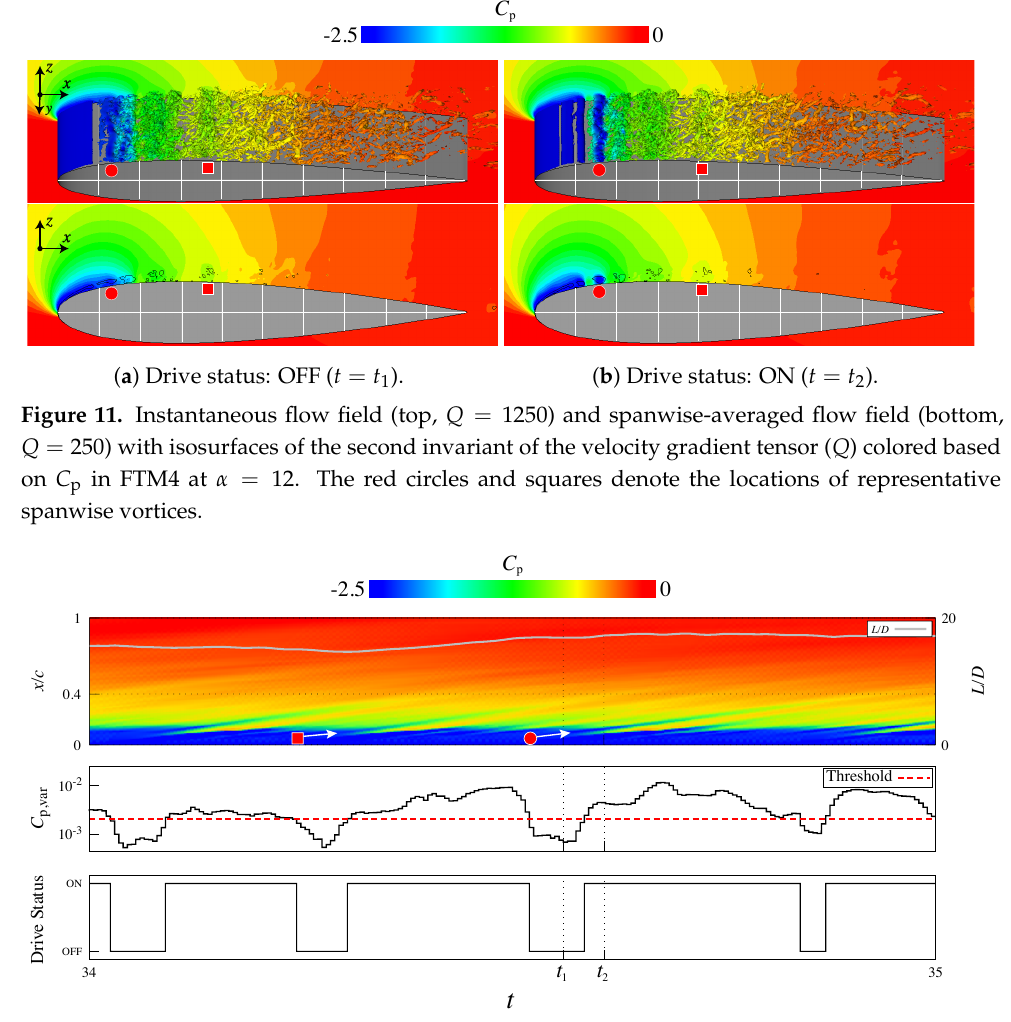
Figure 12. The time histories of L / D , C p,var at the pressure sensor and the drive status of the plasma actuator in FTM4 from the top to bottom. The top figure overlaps with the distribution of the spanwise-averaged C p on the upper surface of the airfoil in the x / c - t domain. The red symbols and arrows represent the characteristic vortex positions and their